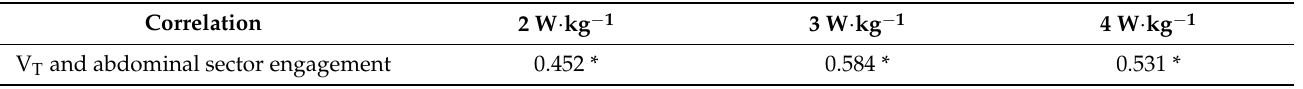
Table 3. Pearson correlation coefficient of change in tidal volume and abdominal probe pressure.